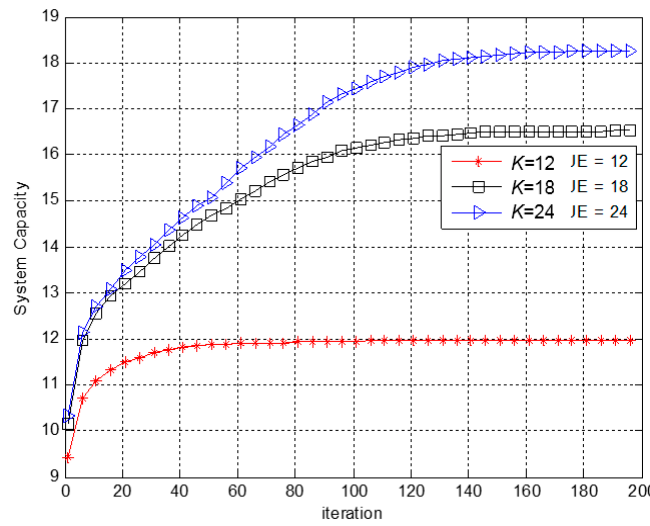
Figure 3. Simulation results of SPSO method with M = 10.